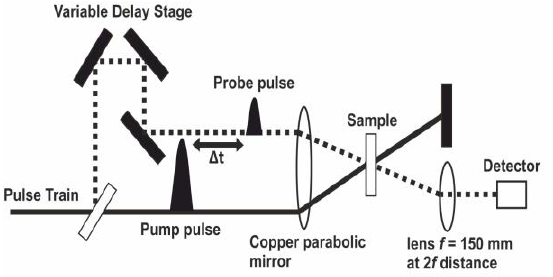
Fig. 1. Optical scheme of the "pump-probe" system at the NovoFEL.